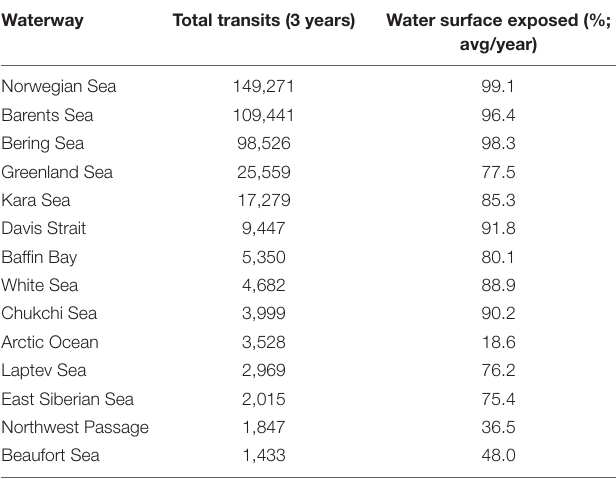
TABLE 4 | Total number of transits and percent surface area exposed to vessel traffic, excluding all fishing vessel operations, for each body of water in the study